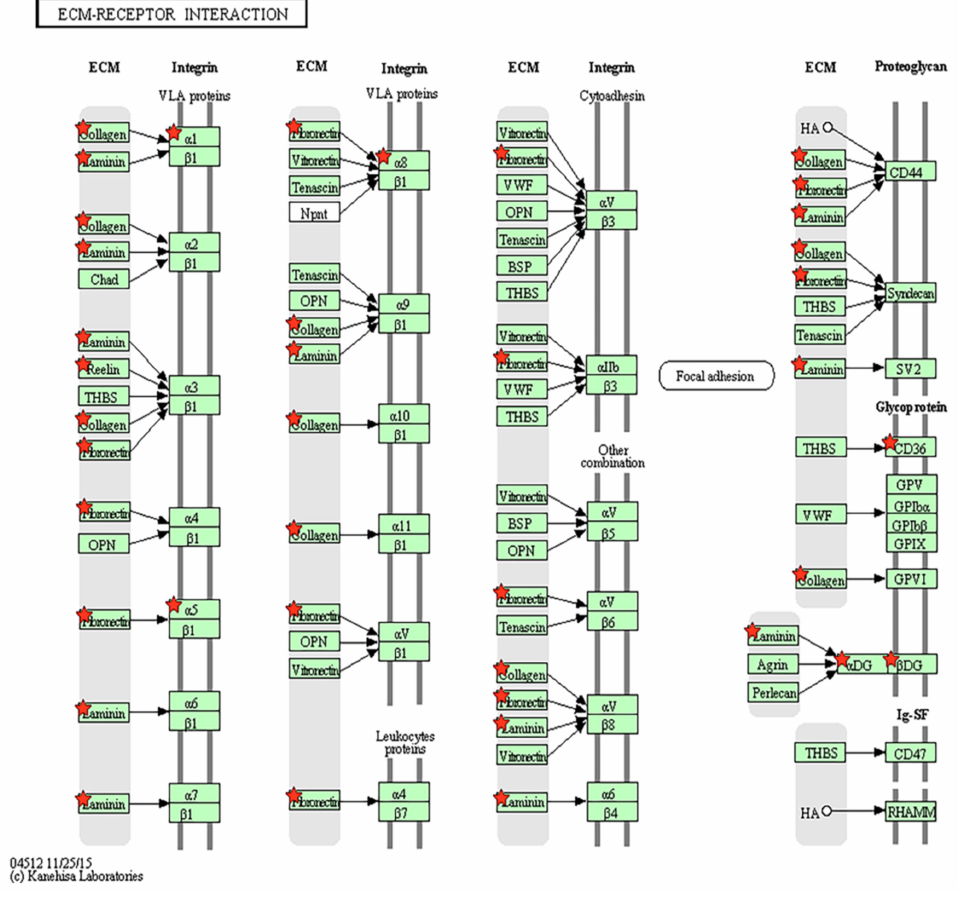
Figure 3. Illustration of extracellular matrix (ECM)-receptor interactions described in the Kyoto Encyclopedia of Genes and Genomes (KEGG) pathway. The KEGG pathway results generated using the DAVID program are shown above. Parkinson’s disease is associated with changes to ECM-related factors, including 10 selected down-regulated genes marked with red stars: CD36 , ITGA5 , LAMA5 , ITGA8 , COL6A3 , COL6A2 , ITGA1 , DAG1 , RELN , COL5A3